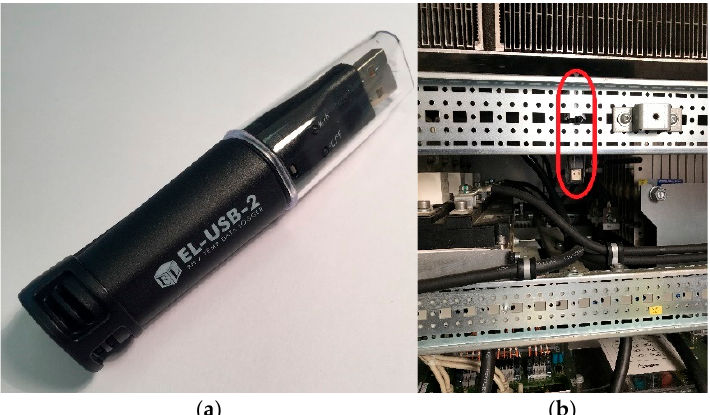
Figure 2. ( a ) Temperature and humidity logger used for the field measurements; ( b ) Logger in- stalled inside a power-converter cabinet of a wind turbine in vicinity of the power modules; photos: ( a ) Fraunhofer IWES; ( b ) courtesy of Energiekontor, Bremerhaven, Germany.